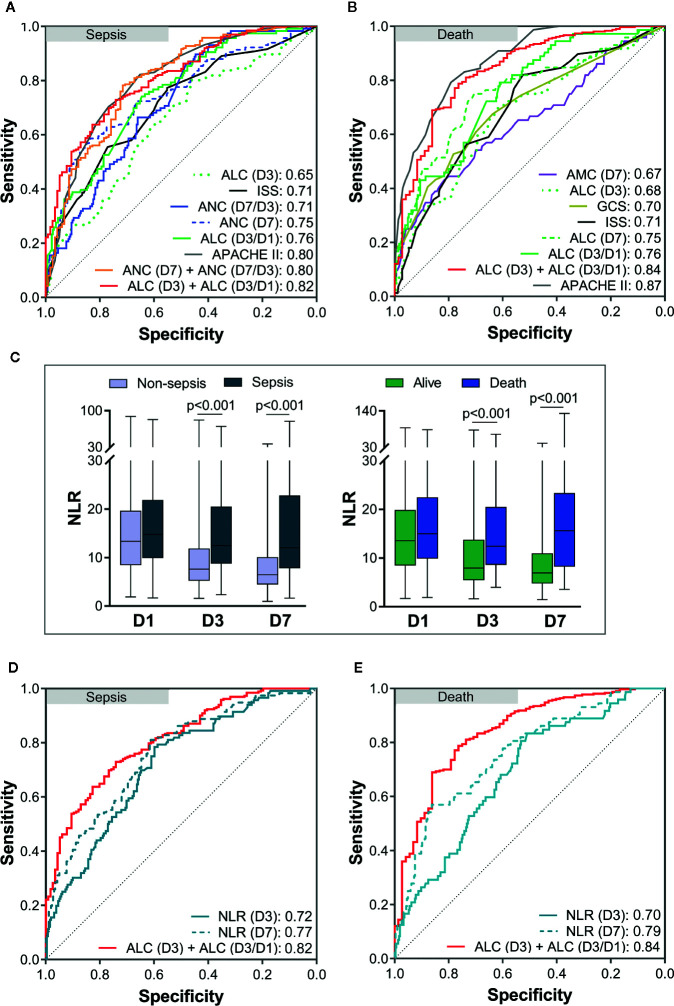
Analyses of receiver operating characteristic (ROC) curves to compare the predictive values of risk factors. The areas under the ROC curves (AUC) are presented in the figure. The predictive value of risk factors and the combinations of some risk factors for sepsis (A) and death (B). Comparison of the neutrophil:lymphocyte ratio (NLR) between each two groups (C). The predictive value of the NLR (D3) and NLR (D7) for sepsis (D) and death (E) was lower than that of a combination of the ALC (D3) and ALC (D3/D1). APACHE II, Acute Physiology and Chronic Health Evaluation II; ISS, Injury Severity Score; GCS, Glasgow coma scale; ANC, absolute neutrophil count; ALC, absolute lymphocyte count; AMC, absolute monocyte count; D1, day-1; D3, day-3; D7, day-7.